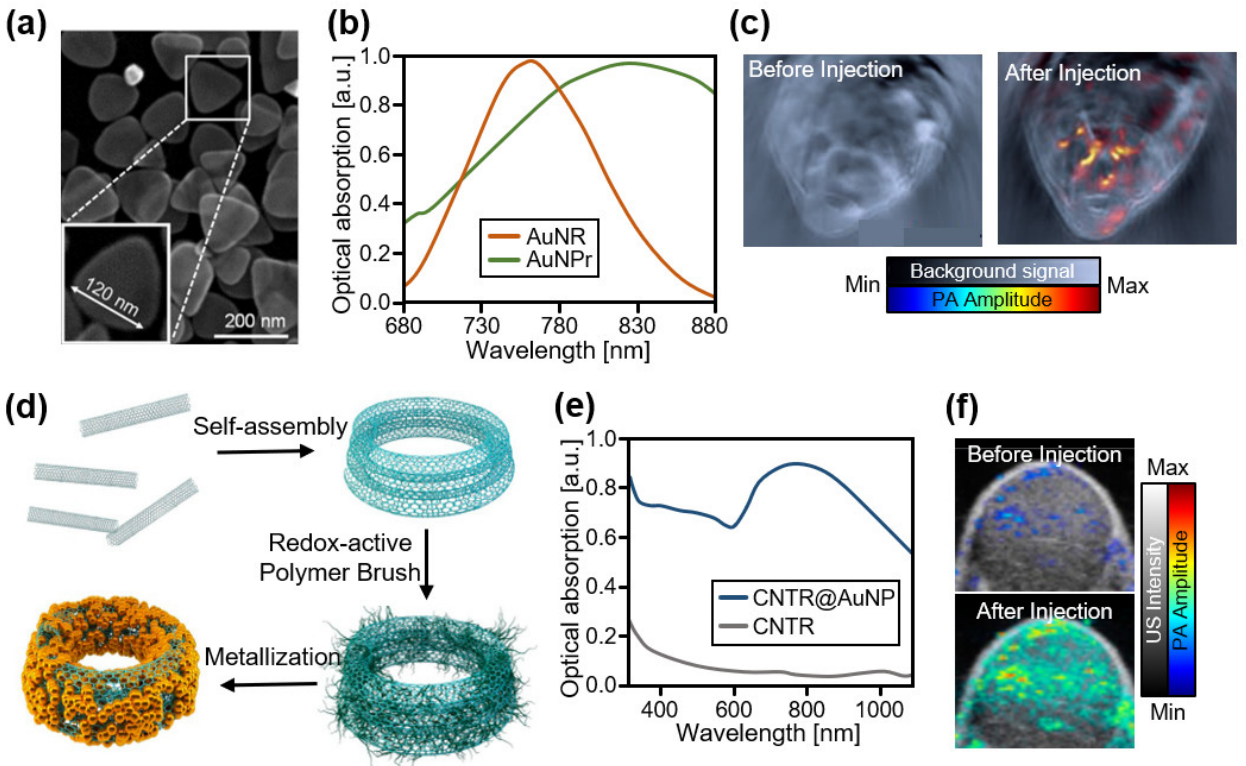
Figure 5. Contrast-enhanced PA images of AuNPs in the high NIR-I region. ( a ) The triangular structure of AuNPrs captured from an electron microscope. ( b ) Optical absorption spectra of AuNPrs and AuNPs, showing the shift. ( c ) Contrast-enhanced PA images of tumors in mice before and after injection of AuNPrs. Reprinted with permission from Ref. [101]. 2013, Wiley. ( d ) Schematic illustration for the synthesis of CNTRs. ( e ) Optical absorption spectra of CNTRs with and without AuNP coating. ( f ) Contrast-enhanced PA images of tumors in mice before and after injection of CNTRs. PA, photoacoustic; NIR, near-infrared; AuNP, gold nanoparticle; AuNPr, gold nanoprism; CNTR, carbon nanotube ring. Reprinted with permission from Ref. [102]. 2016, ACS Publications.